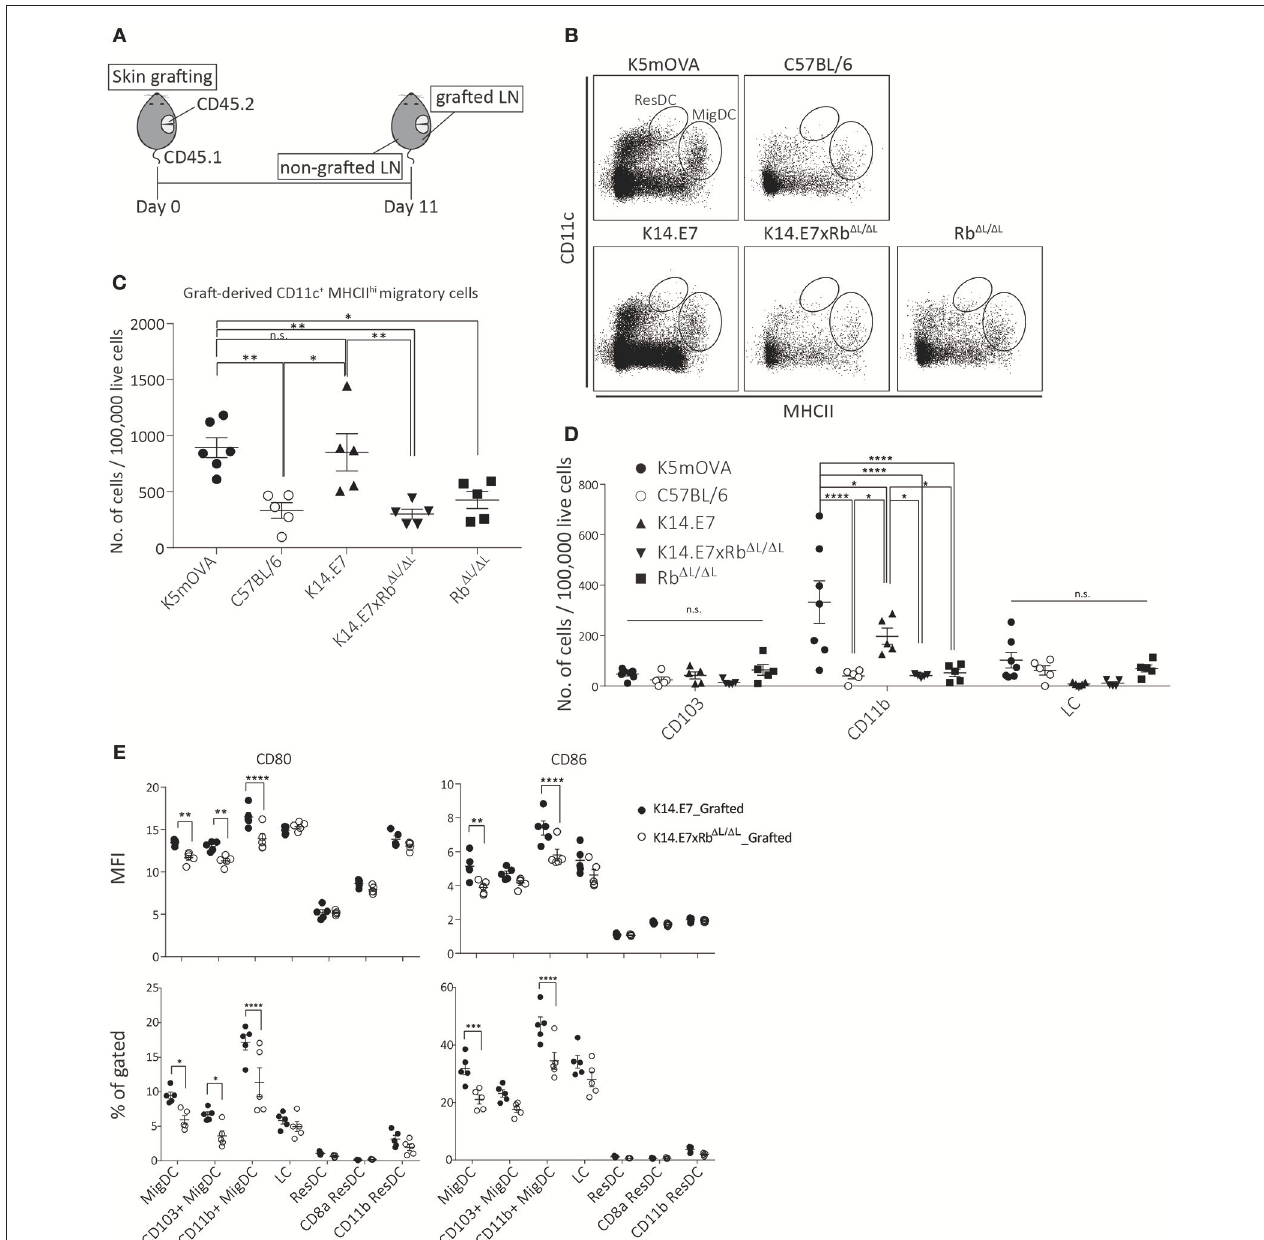
FIGURE 3 | The presence of K14.E7xRb 1 L /1 L and K14.E7 DCs from grafted skin in the draining lymph node. Skin-derived DC in graft draining and control lymph node of CD45.1 recipients receiving K5mOVA, C57BL/6, K14.E7, K14.E7xRb 1 L /1 L , or Rb 1 L /1 L (CD45.2) skin grafts. (A) experimental outline. Draining lymph nodes (axillary and iguanual) were harvested 11 days after grafting from either grafted side or non-grafted side of one graft recipient. (B) representative plots showing graft-derived (CD45.1–) DC under live CD45.1–gate. (C) quantitative result of migratory DC [vertical oblong gate in (B) ] in grafted draining lymph node of recipients receiving indicated type of skin grafts. Plot showing the number of cells per 100,000 live cell analyzed. (D) number of cells per 100,000 live cells analyzed of graft-derived MigDC subtypes (CD103 + , CD11b + and LC) from lymph nodes of mice receiving indicated skin grafts. (E) MFI (top) and percentage (bottom) of CD80 and CD86 positive cells of various DC subtypes in grafted-drianing lymph nodes receiving either K14.E7 (closed circle) or K14.E7xRb 1 L /1 L (opened circle) skin graft. All statistics were done with one-way ANOVA with Bonferroni post-test. Plots show mean value with SEM. Result significance was shown, where * p < 0.05, ** p < 0.01, *** p < 0.001, and **** p < 0.0001.